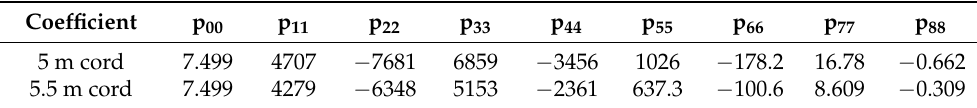
Table 3. The coefficients of the F es ,1 approximation function (stretching force) for elastic cords of 5 m and 5.5 m in